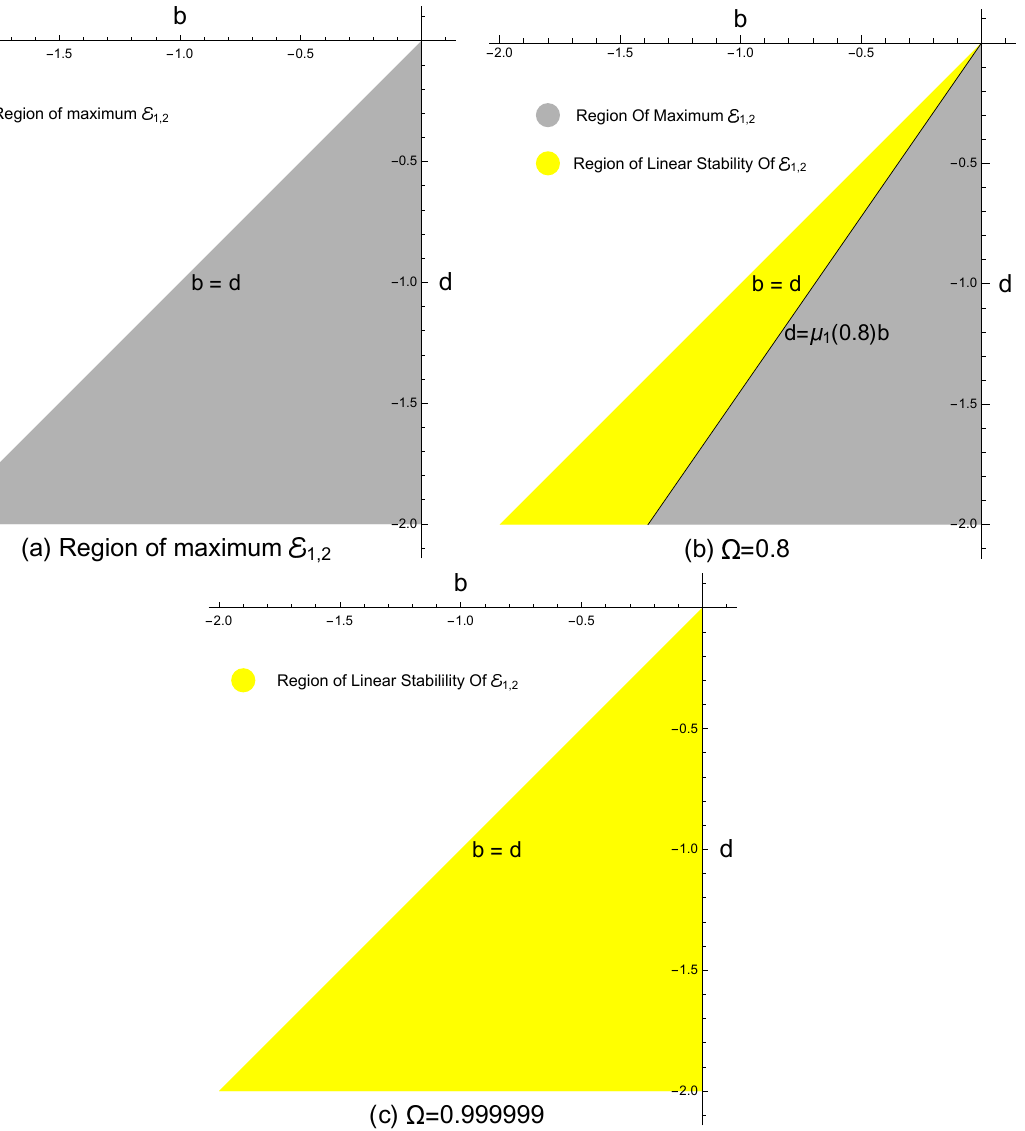
Figure 2. Regions of stability and instability for the equilibrium position E 1,2 in the plan of the parameters b ,